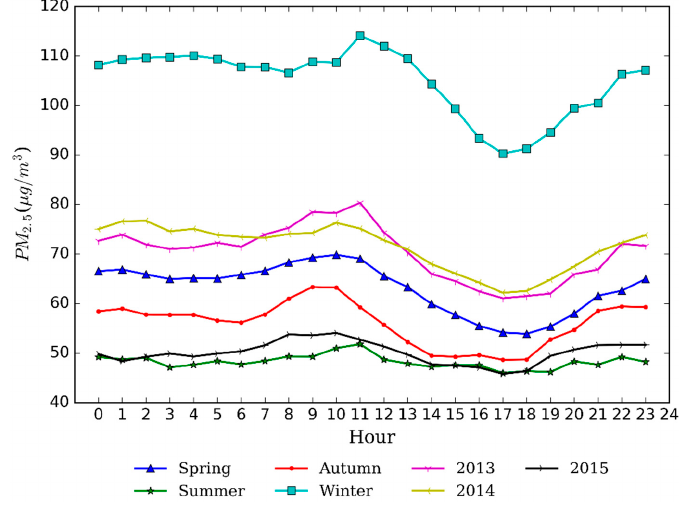
Figure 5. Diurnal variation of PM 2.5 concentrations in Nanjing.